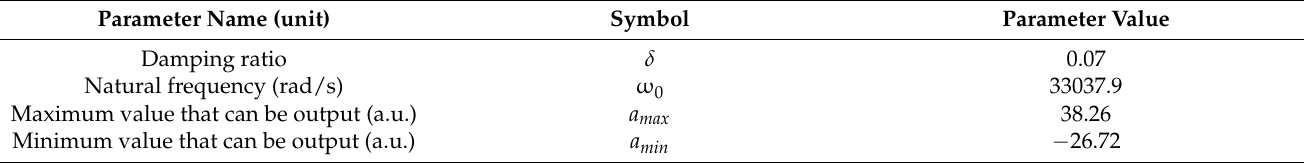
Figure 6. Comparison of the experimental data and mathematical model results under the sweep- ing amplitude acoustic attack. 3.3. The Mathematical Model Fit with Acoustic Injection Experiment with Frequency Sweeping In the acoustic attack experiment with amplitude sweeping, we set a c = B · sin[ 2 π f ( 0.8t + 0.02t 2 )]. The sweeping frequency ranged from 0.8 f to 1.2 f . It took 10 s to complete the process. Signal clipping occurred when the output exceeded the range of the amplifier and the first-order low-pass filter was realized via data averaging. After setting the ap- propriate simulation parameters, the simulation results were plotted. The time-domain response of linear frequency sweeping was plotted in Figure 7a. We set the amplifier’s bilateral asymmetric cutoff range to a min ~ a max . In Figure 7b, the blue line represents the am- plifier’s failure and the orange line shows the detailed result after the LPF. The simulation results in Figure 7b were compared with the experimental results in Figure 2 and then plotted in Figure 7c. The R-squared coefficient R 2 was used to represent the fitting degree of the simulation and experiment. After MATLAB calculation, we found that R 2 = 0.9888.